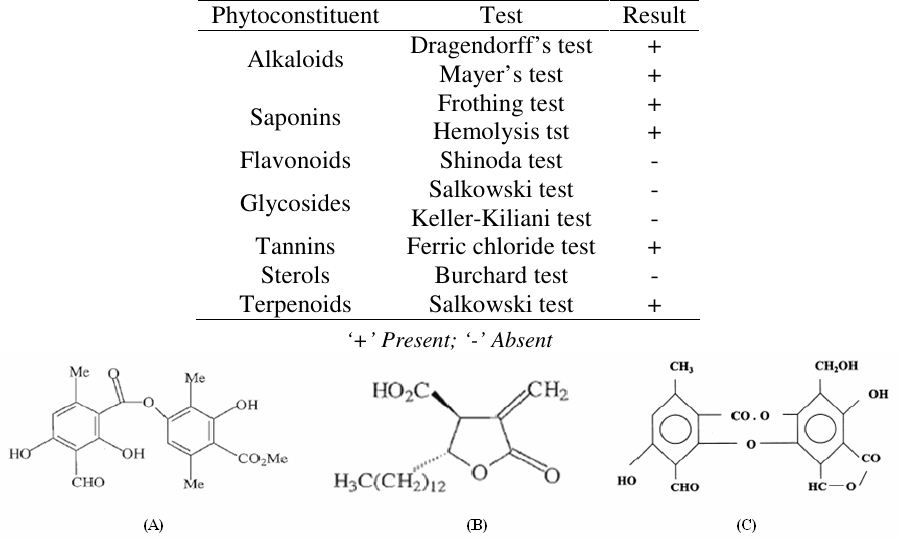
Table 1. Phytochemicals detected in methanol extract of E. cirrhatum